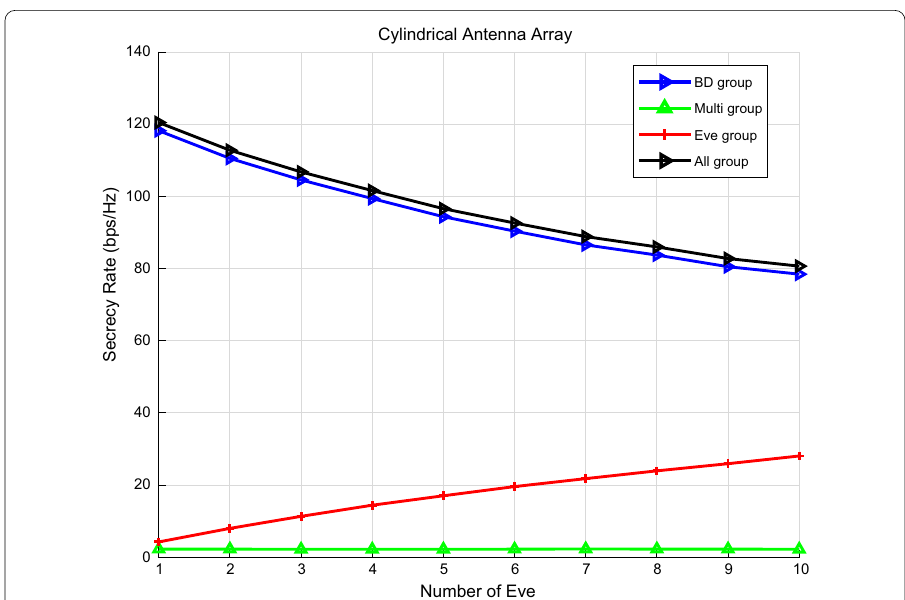
Fig. 4 Secrecy rate under cylindrical antenna array. This figure shows the secrecy rate yielded when the antenna array is cylindrical antenna array, where the number of Eves ranges from 1 to 10. We evaluate the performances of four groups including BD group, Multi-group, Eve group, and All group